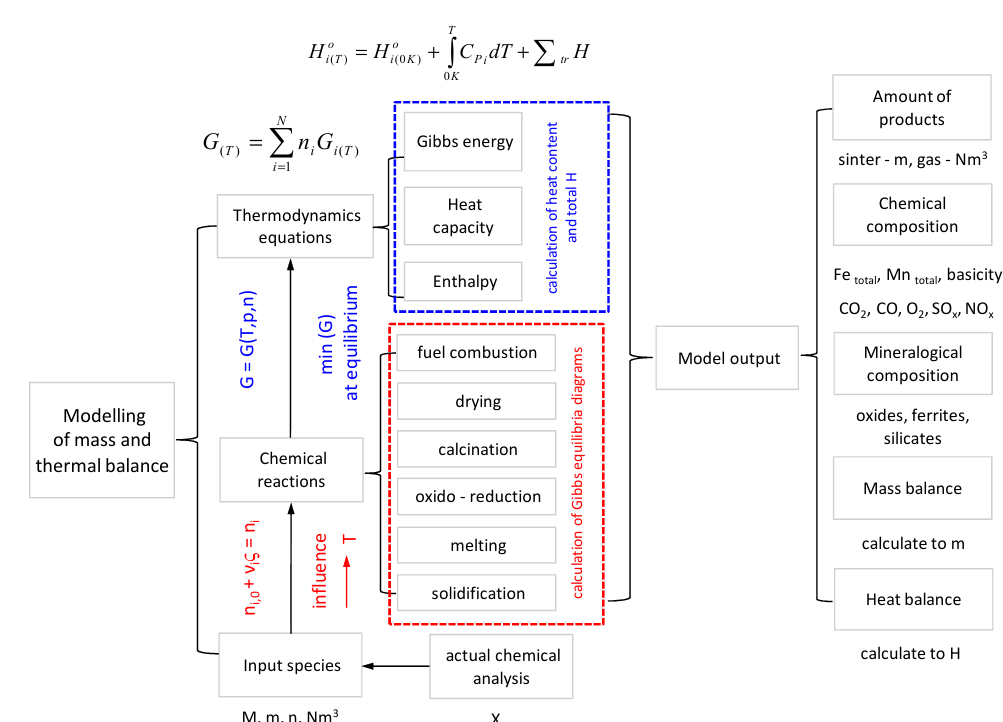
Figure 3. Scheme presenting the global method with modelling the mass and thermal balance.